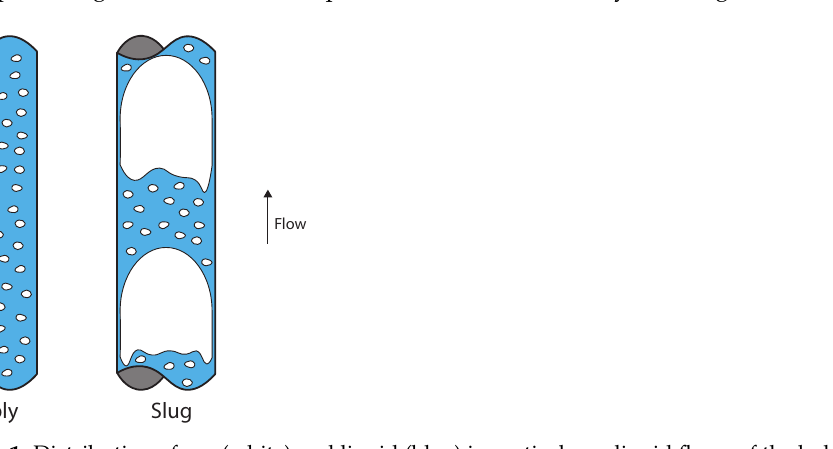
Figure 1. Distribution of gas (white) and liquid (blue) in vertical gas–liquid flows of the bubbly ( left ) and slug ( right ) flow